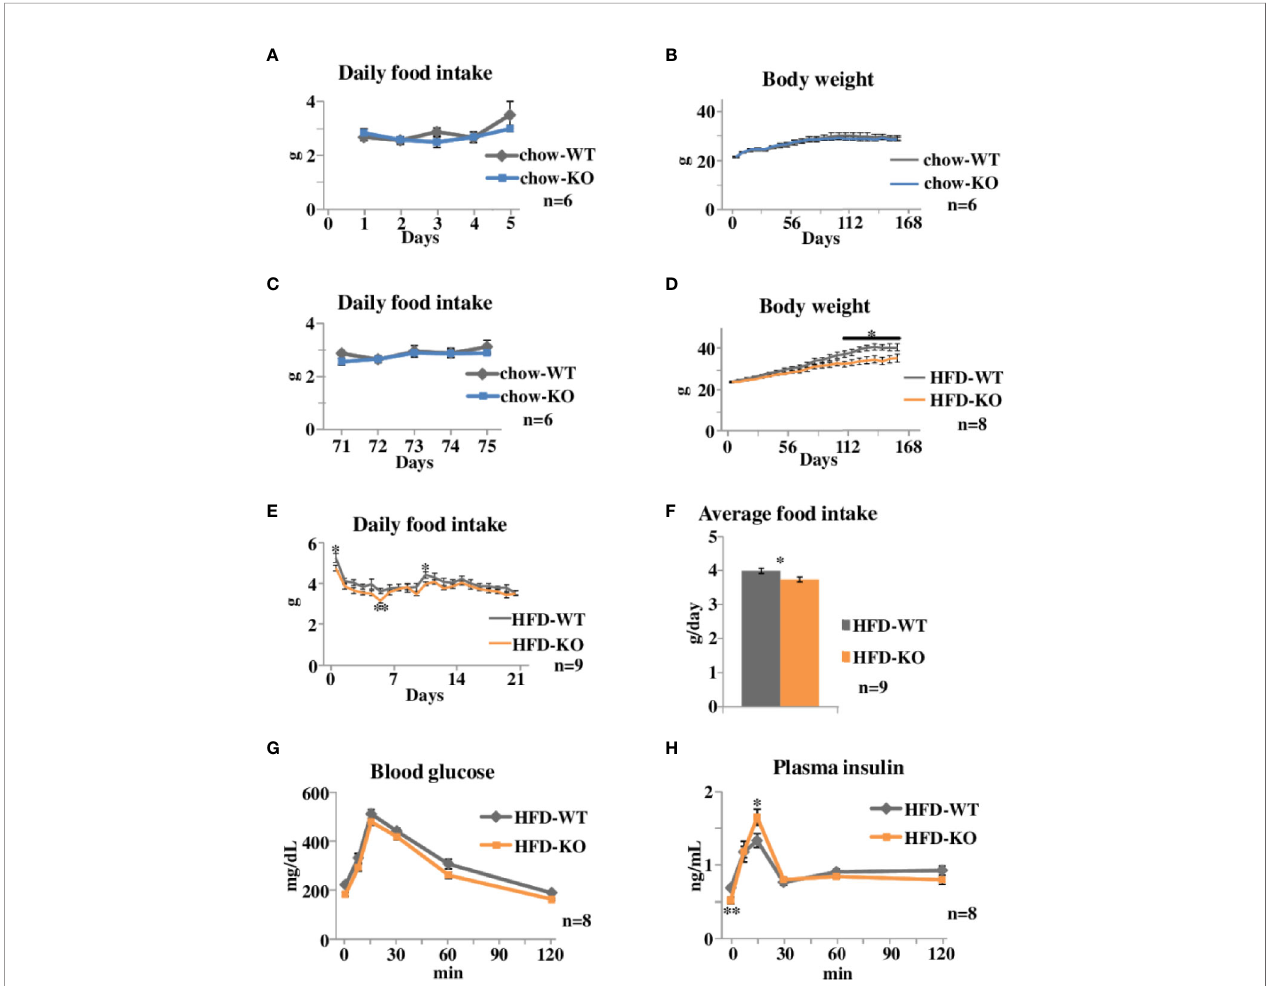
FIGURE 1 | Time courses of body weight changes, food intake, and oral glucose tolerance tests in PAI-1 knockout (KO) mice fed chow or the saf fl ower oil-rich high fat diet (HFD). (A) Daily food intake of chow-KO and chow-WT mice from the 1st day through the 5th day of observation. Each bar represents the mean ± SE of n = 6 mice. (B) Body weight of chow fed PAI-1 KO mice (chow-KO) and wild-type (WT) control mice (chow-WT). Eight-week-old mice were weighed weekly. Each bar represents the mean ± SE of n = 6 mice. (C) Daily food intake of chow-KO and chow-WT mice from the 71st day through the 75th day of observation. Each bar represents the mean ± SE of n = 6 mice. (D) Body weight of saf fl ower oil-rich high fat diet (HFD) fed PAI-1 KO mice (HFD-KO) and WT control mice (HFD-WT). Eight-week-old mice were fed saf fl ower oil-rich HFD and then were weighed weekly. Each bar represents the mean ± SE of n = 8 mice. (E) Daily food intake of HFD- KO and HFD-WT mice from the 1st day through the 21st day of observation. Each bar represents the mean ± SE of n = 9 mice. (F) Average food intake of HFD-KO and HFD-WT mice from the 1st day through the 21st day of observation. Each bar represents the mean ± SE of n = 9 mice. (G) Blood glucose levels and (H) plasma insulin levels during oral glucose tolerance tests performed 21 days after the initiation of saf fl ower oil-rich HFD feeding. Results are expressed as mean ± SE of n = 8 mice. * P < 0.05 and ** P <